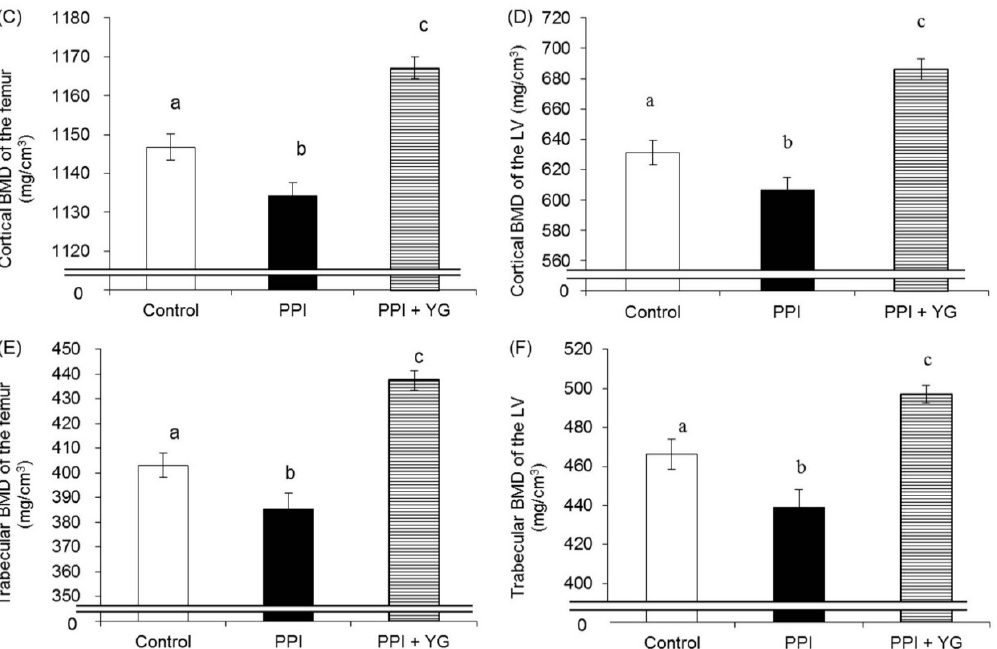
Figure 1. Effects of proton pump inhibitor (PPI) administration and intake of a combination of yogurt and galactooligosaccharides (YG) on bone mineral density (BMD) in adult rats. ( A ) BMD of the femur; ( B ) BMD of the lumbar vertebrae (LV); ( C ) Cortical BMD of the femur; ( D ) Cortical BMD of the LV; ( E ) Trabecular BMD of the femur; ( F ) Trabecular BMD of the LV. Values are presented as the mean ± SE. a, b, c: bars with different letters are significantly different ( p < 0.05).